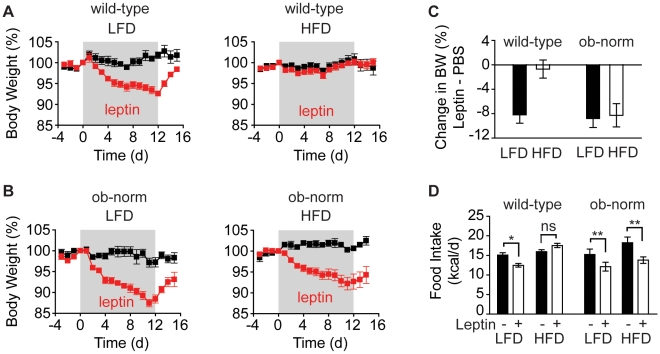
Leptin sensitivity in a 12-day infusion.
A. Body weight of wild-type animals that received a leptin (red) or PBS (black) infusion for 12-days (gray block). B. Body weight of ob-norm animals that received a leptin (red) or PBS (black) infusion for 12-days (gray block). C. Difference in weight loss between leptin and vehicle for each cohort over the 12-day leptin infusion. Values are expressed as percentage change in body weight. D. Average daily food intake during the 12-day infusion for animals in each cohort.